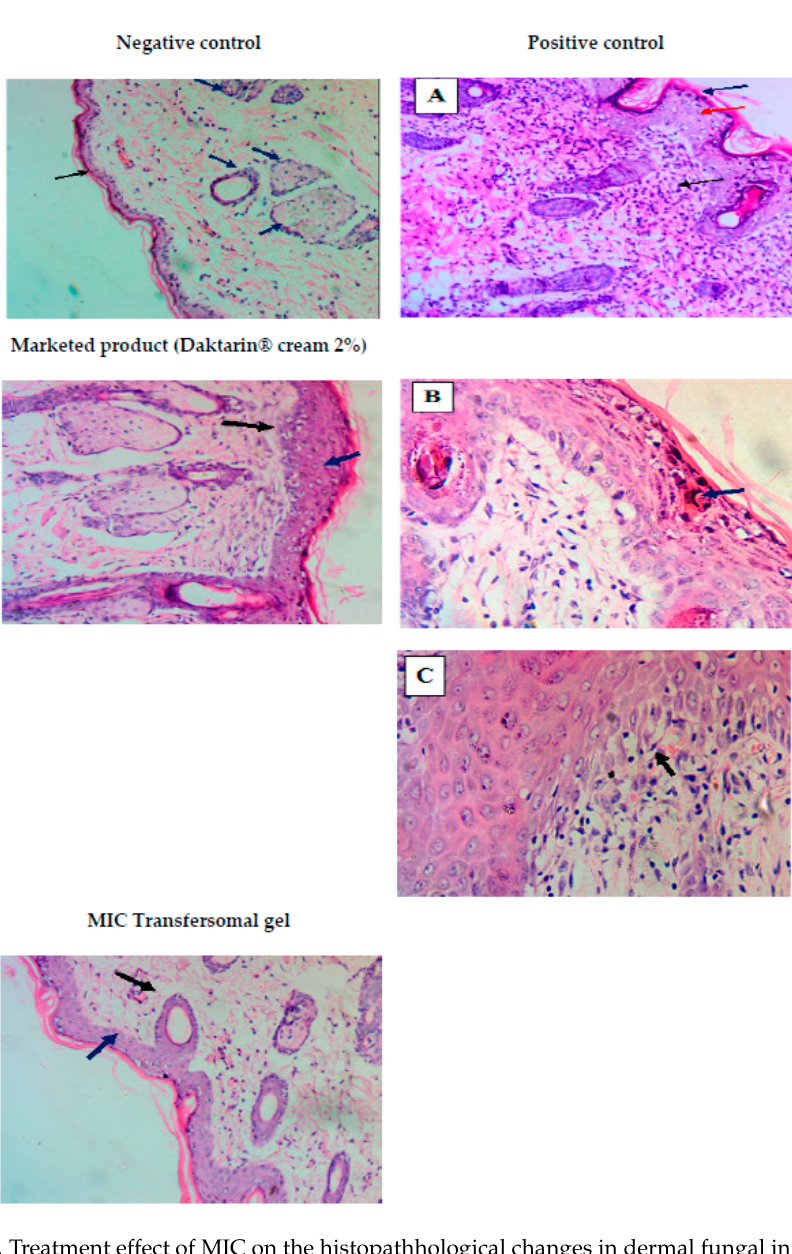
Figure 12. Treatment effect of MIC on the histopathhological changes in dermal fungal infection rats using Candida albicans : clinical postmortem examination histological images (H and E X 20 and 40) for the negative control, positive control, Daktarin® cream 2%, and MIC transfersomal gel.